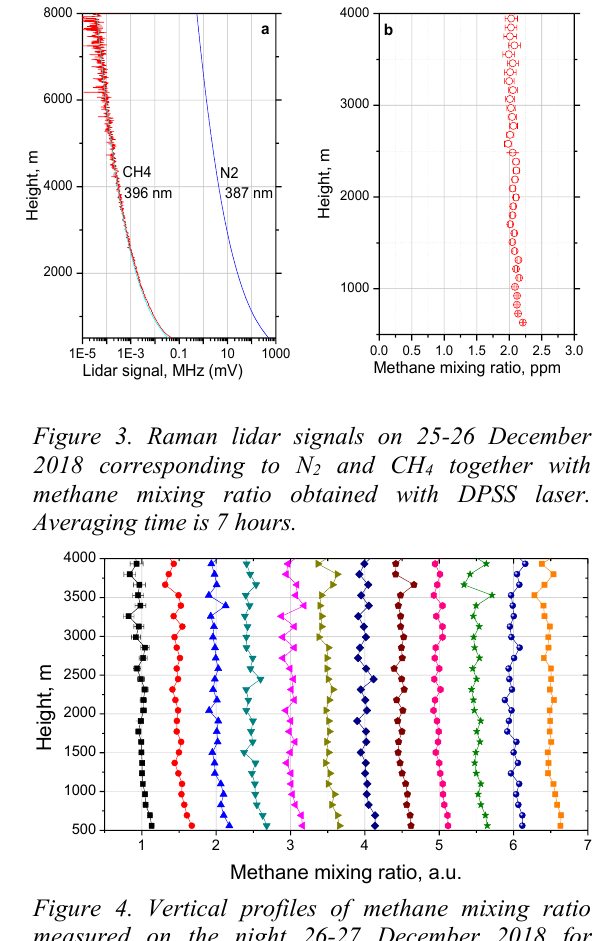
Figure 4. Vertical profiles of methane mixing ratio measured on the night 26-27 December 2018 for period 18:00 – 06:00 UTC. Profiles are averaged for 1 hour and shifted relatively to each other by 0.5. Mixing ratios are not calibrated and the value 1.0 corresponds to approximately 2